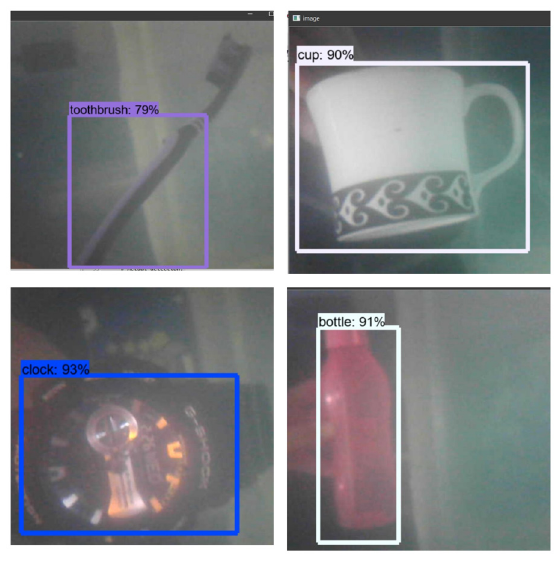
Figure 4. Objects detected under